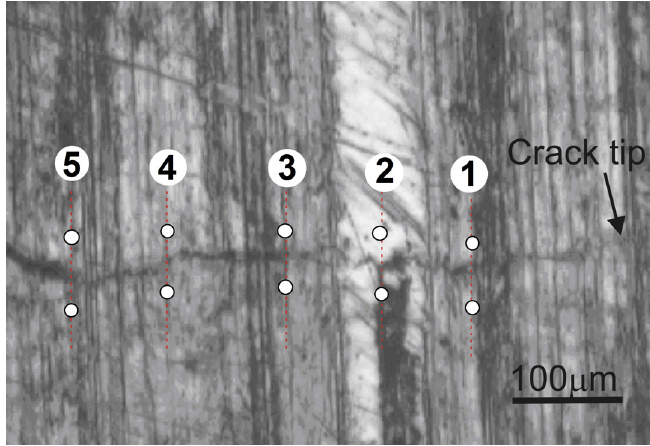
Figure 2: Typical image showing the crack tip, together with the five pairs of measurement points.